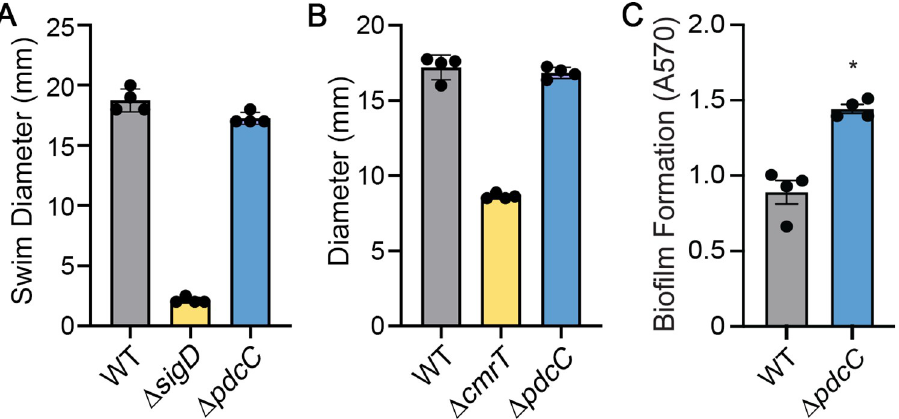
Fig 6. PdcC contributes to inhibition of biofilm formation, but not swimming or surface motility. (A) S wimming motility in 0.5x BHIS-0.3% agar after 48 hrs. A non-motile mutant ( Δ sigD ) served as a negative control. (B) Surface motility on BHIS-1.8% agar-1% glucose after 6 days. A Δ cmrT mutant served as a negative control. (C) Biofilm formation was measured by crystal violet staining after 24 hours of growth in BHIS broth. (A-C) Means and standard error are shown. Symbols indicate values from independent biological samples. � p < 0.05 by Mann-Whitney test.